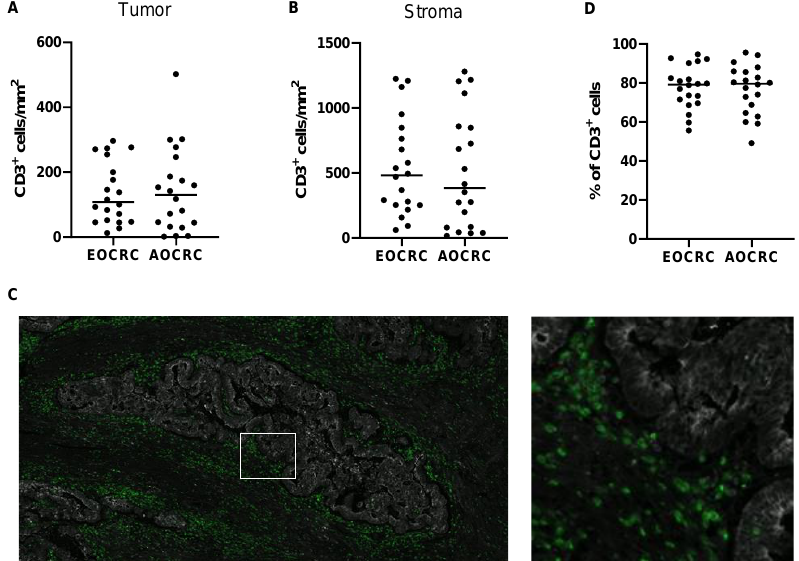
Figure 1. Density of CD3 + T cells. The density of CD3 + T cells in tumors from early-onset (EOCRC) and average-onset colorectal cancer (AOCRC) patients was determined by immunofluorescence in tumor tissue ( A ) and tumor stroma ( B ). ( C ) Representative immunofluorescence image from an EOCRC patient with tumor cells (panCK, grey) and CD3 + T cells (green). Magnification 50 × left and 300 × right. ( D ) Percentage of all CD3 + cells located in the stroma. Symbols show individual values, and lines indicate the